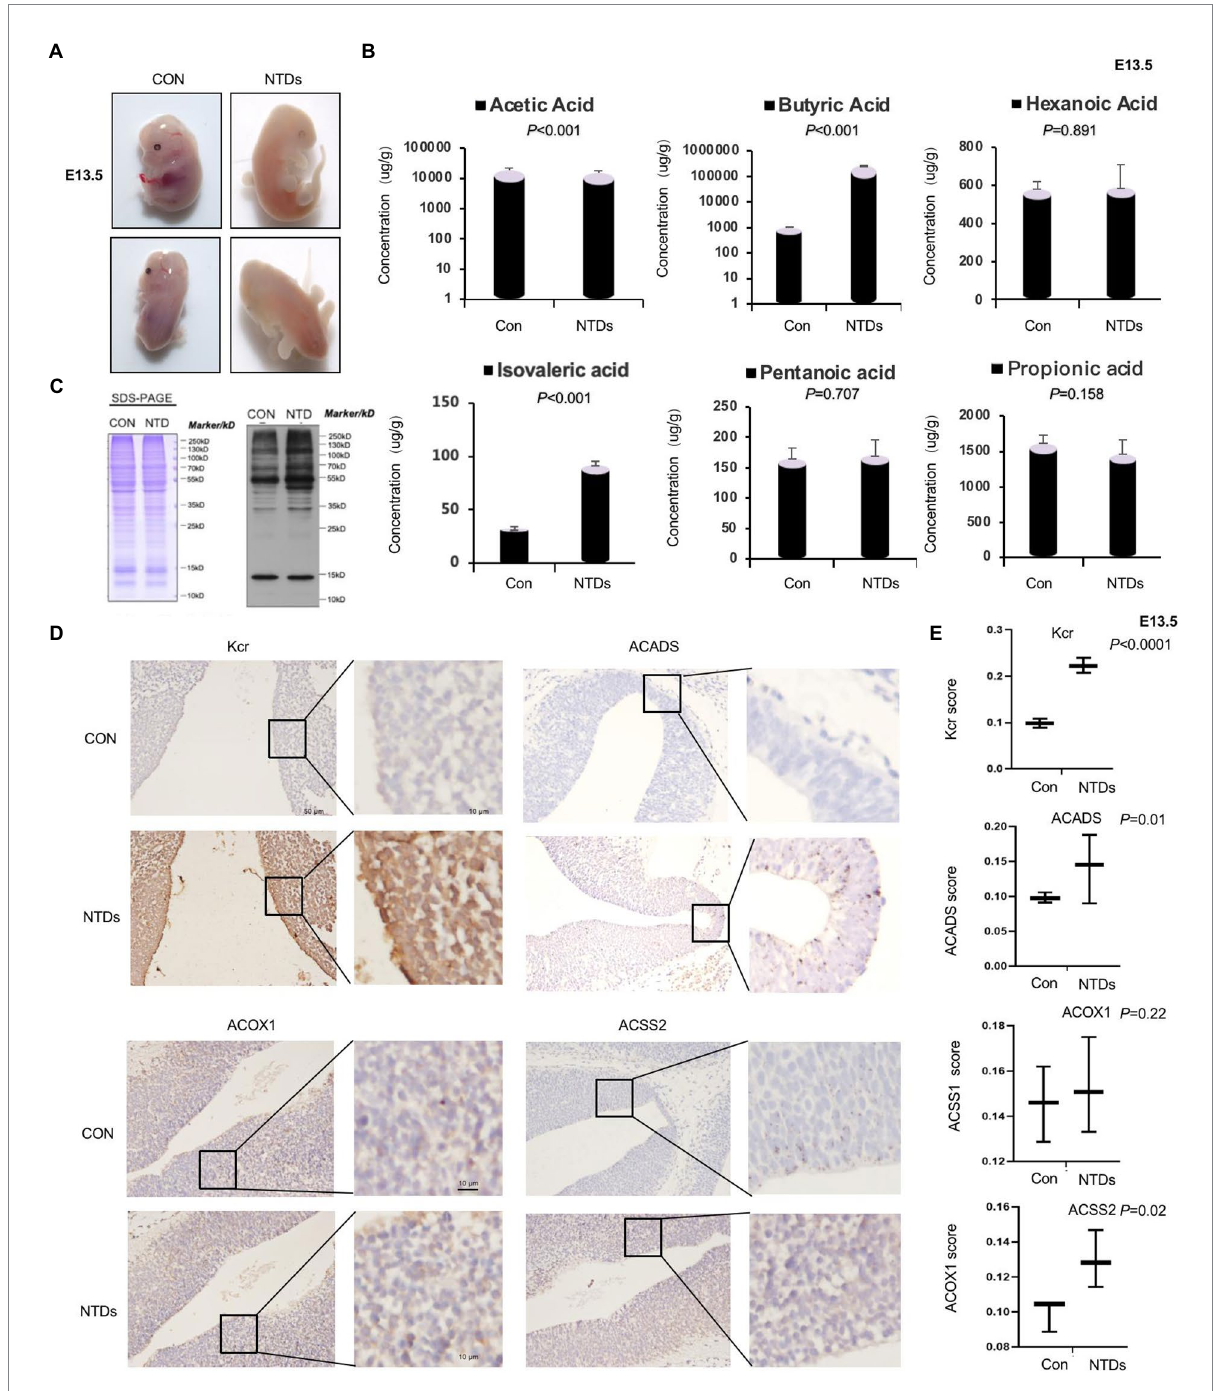
FIGURE 1 Folate deficiency reduced ACSS2 levels in mouse Neural tube defects (NTDs). (A) Methotrexate (MTX) and folate deficiency-induced NTDs in C57BL/6 mouse embryos at 13.5 day. (B) SDS-PAGE analysis of lysates of cranial neural tissue in normal and folate deficiency-induced mouse NTDs harvested at E13.5. Western blot analysis of tissue lysate with anti-crotonyllysine antibodies. (C) Targeted short-chain fatty acid detection in the cranial neural tissue of normal and folate deficiency-induced mouse NTDs harvested at E13.5 ( n = 6). Analysis of short-chain fatty acids based on the LC–MS/MS platform and absolute quantitative detection of seven short-chain fatty acids: acetic acid, propionic acid, isobutyric acid, isovaleric acid, pentanoic acid, and hexanoic acid. According to the sampling and/or dilution times and other parameters, the metabolite concentration was further calculated, and finally, the absolute content of each metabolite in the actual samples was obtained. (D) Representative images of immunohistochemical staining of Kcr, ACSS2, ACOX1, and ACADS in the cranial neural tissue from E13.5 embryos. (E) Kcr, ACSS2, ACOX1, and ACADS expression scores are shown as box plots, with the horizontal lines representing the median. Data are the mean ± SD. ( n = 3), * p < 0.05, by Student’s t